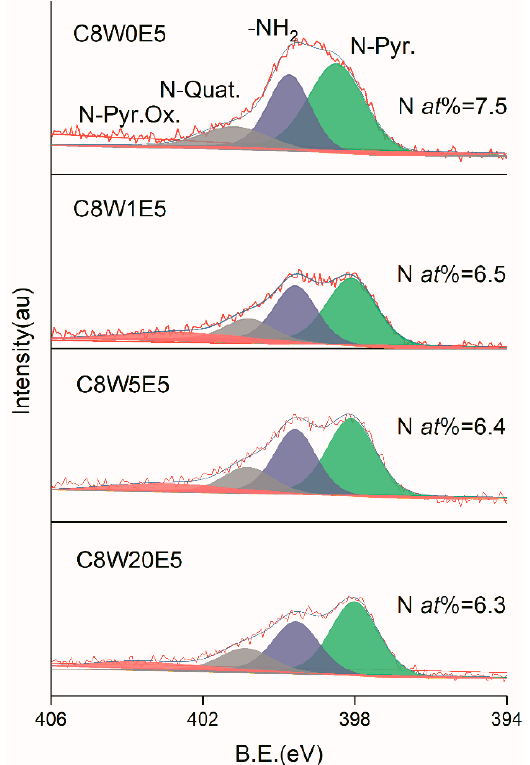
Figure 7. N1s XPS fitting curves of different samples.